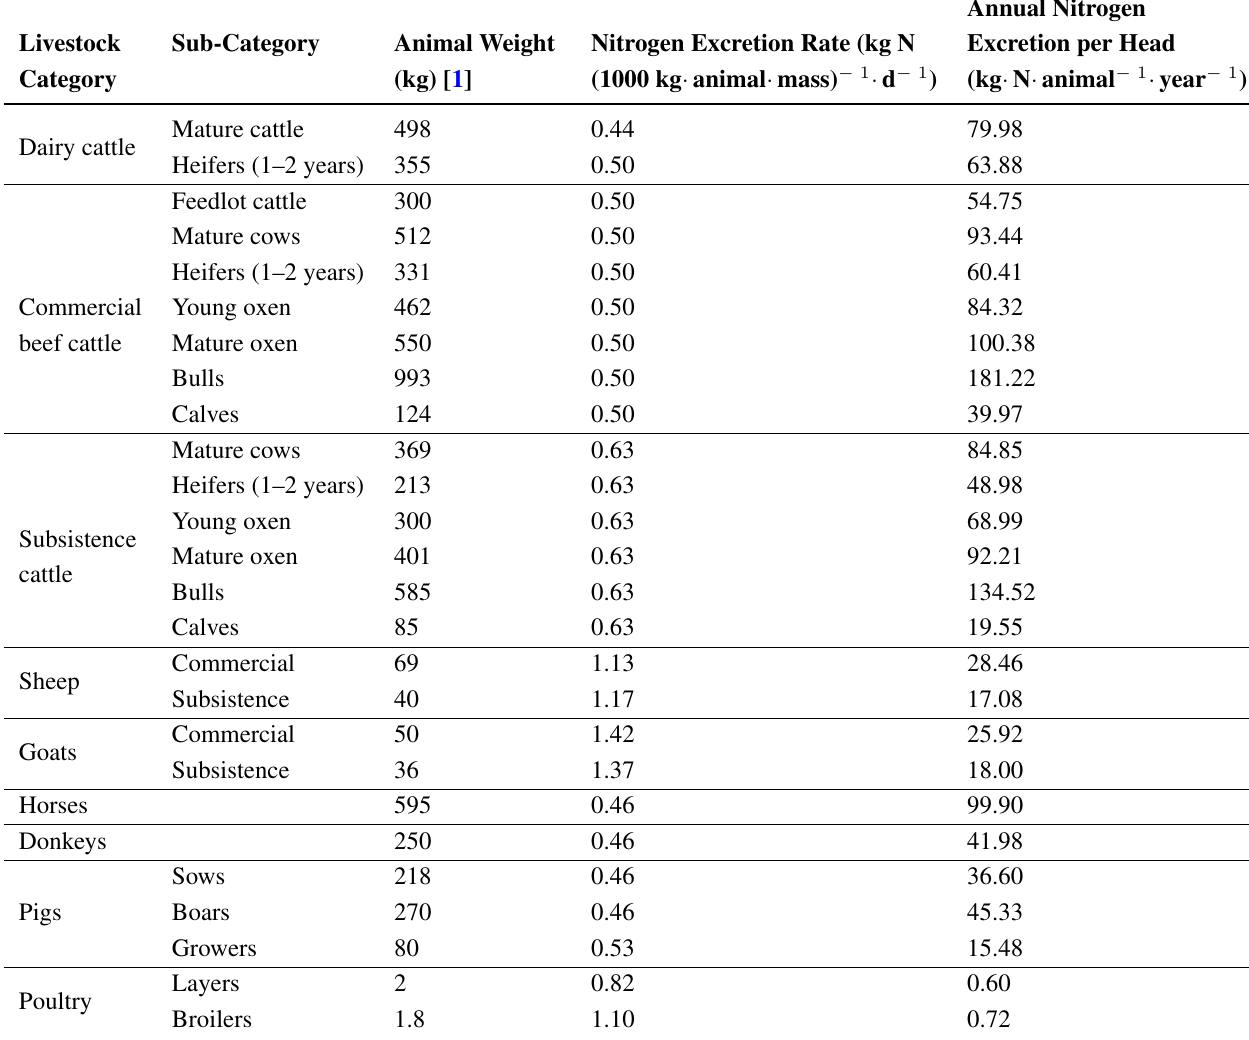
Table 4. Activity data, per livestock category, required for calculating N manure management in